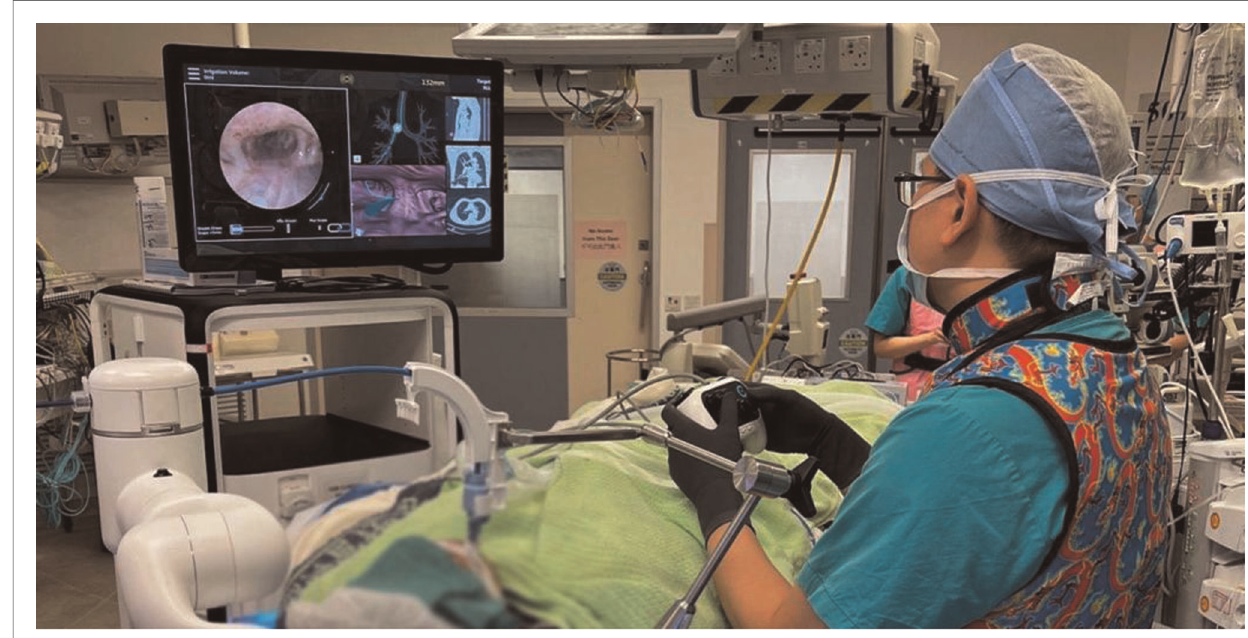
FIGURE 1 | The operator commands the outer sheath and inner bronchoscope via a controller. On the monitor, the left side panel shows the real-time bronchoscopic images, while the right side panels show virtual bronchoscopic and various choices of other views to aid navigation and